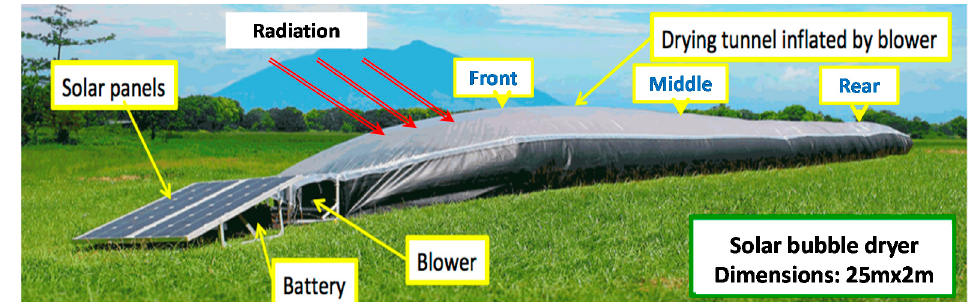
Figure 1. Original Solar Bubble Dryer (SBD) for paddy drying.